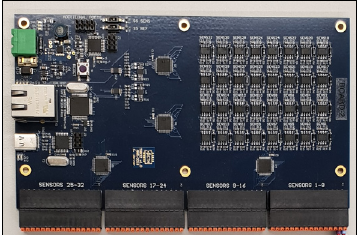
Figure 6. Prototype to read out 32 Negative Temperature Coefficient (NTC) sensors via Ethernet.